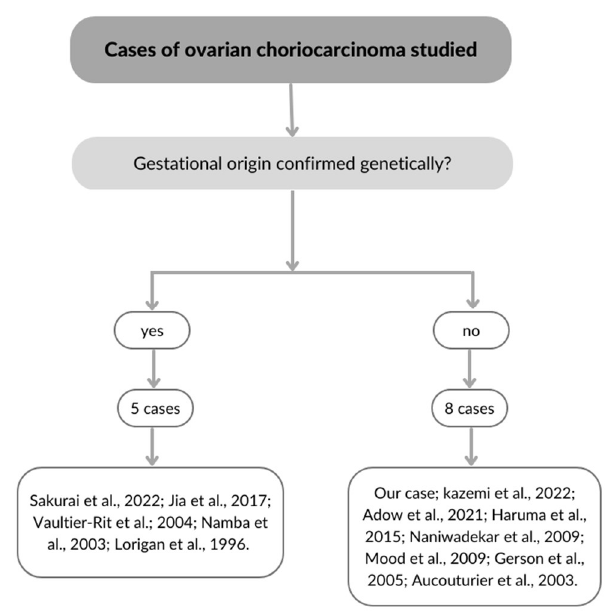
Figure 3. Identified cases of ovarian choriocarcinoma and their genetic